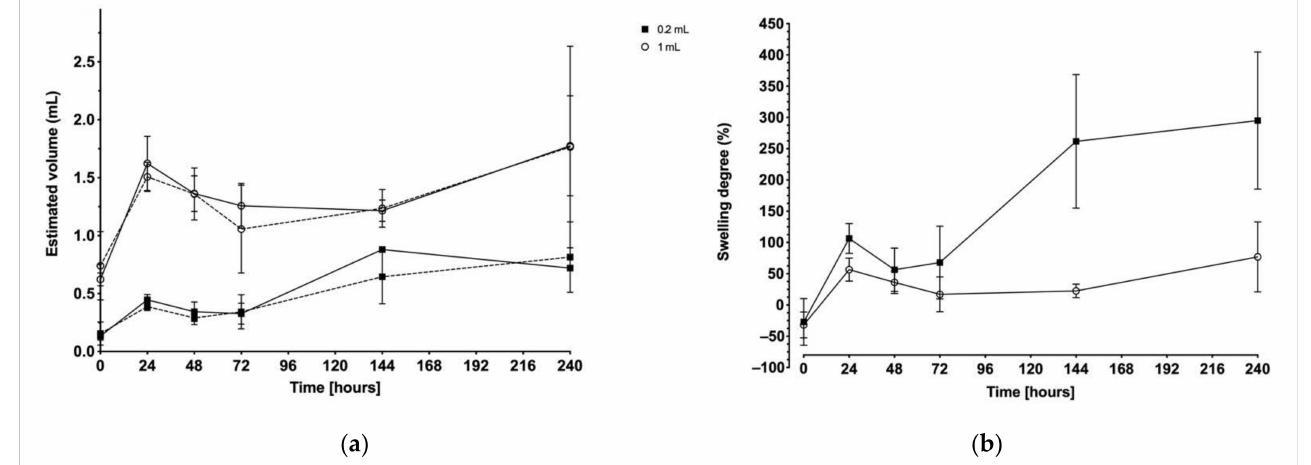
Figure 3. Variation of depot volume over the course of the study (10 days): ( a ) the calculated volumes from both injections are displayed at both injection sites: site 1 as full line; site 2 as dotted line; ( b ) the degree of depot swelling is presented for both volumes as the mean of the two injection